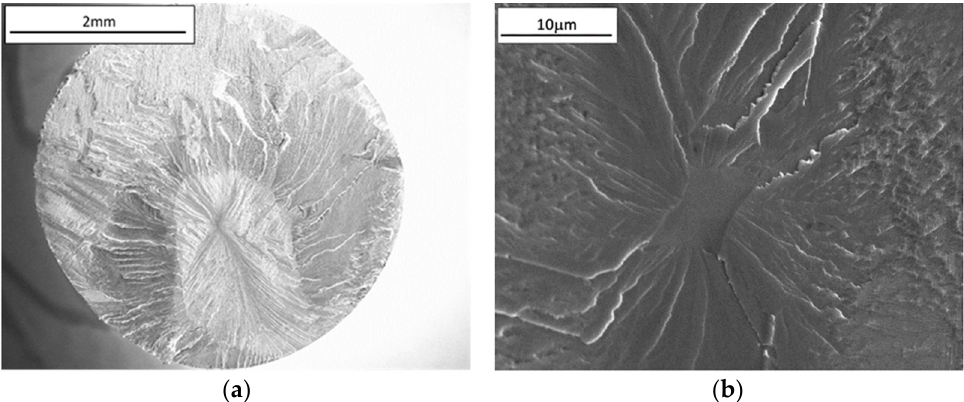
Figure 15. ( a ) Sub-surface initiation in a stress relaxation specimen; ( b ) high magnification view of the initiating facet (i.e., within the bounds of the area indicated in ( a )).